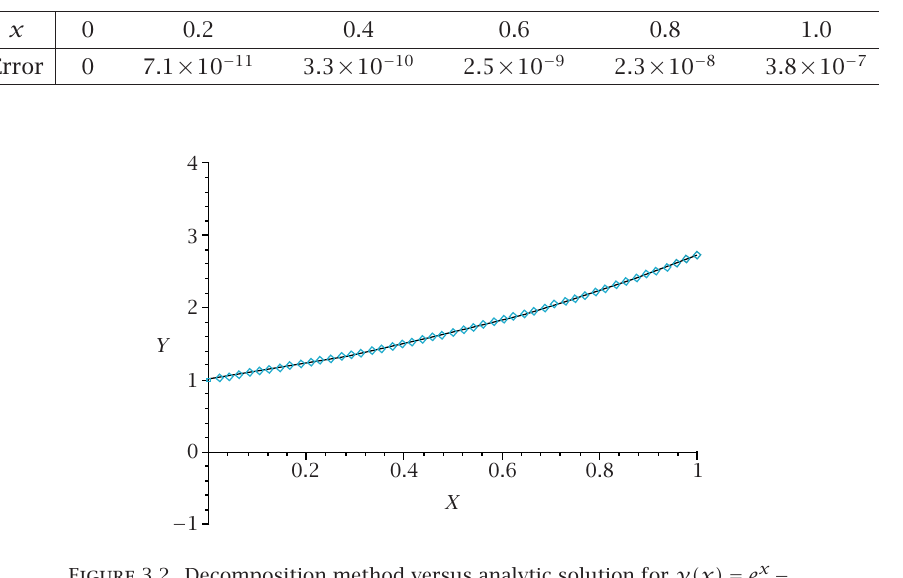
Figure 3.2 . Decomposition method versus analytic solution for y(x) = e x − (cid:16) x 3 dt . ( 1 / 3 )e 3 x + 1 / 3 + 0 [y(t)]